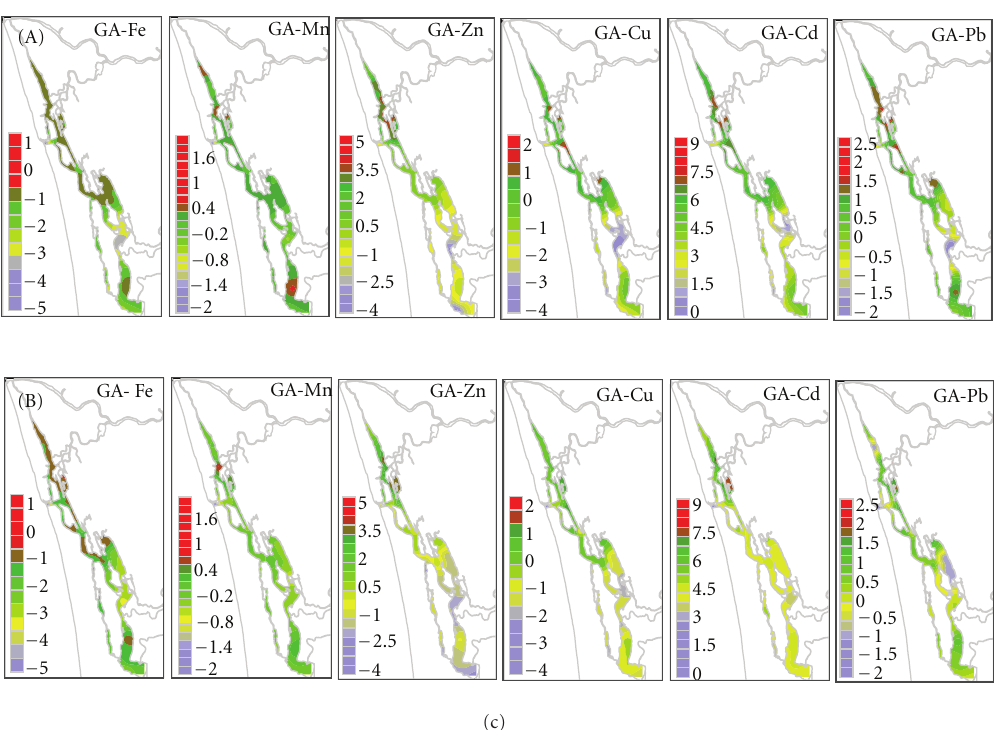
Figure 4: (a) Enrichment factor during monsoon (A) and premonsoon (B) season. (b) Contamination factor during monsoon (A) and premonsoon season (B). (c) Geoaccumulation index during monsoon (A) and premonsoon (B) season.